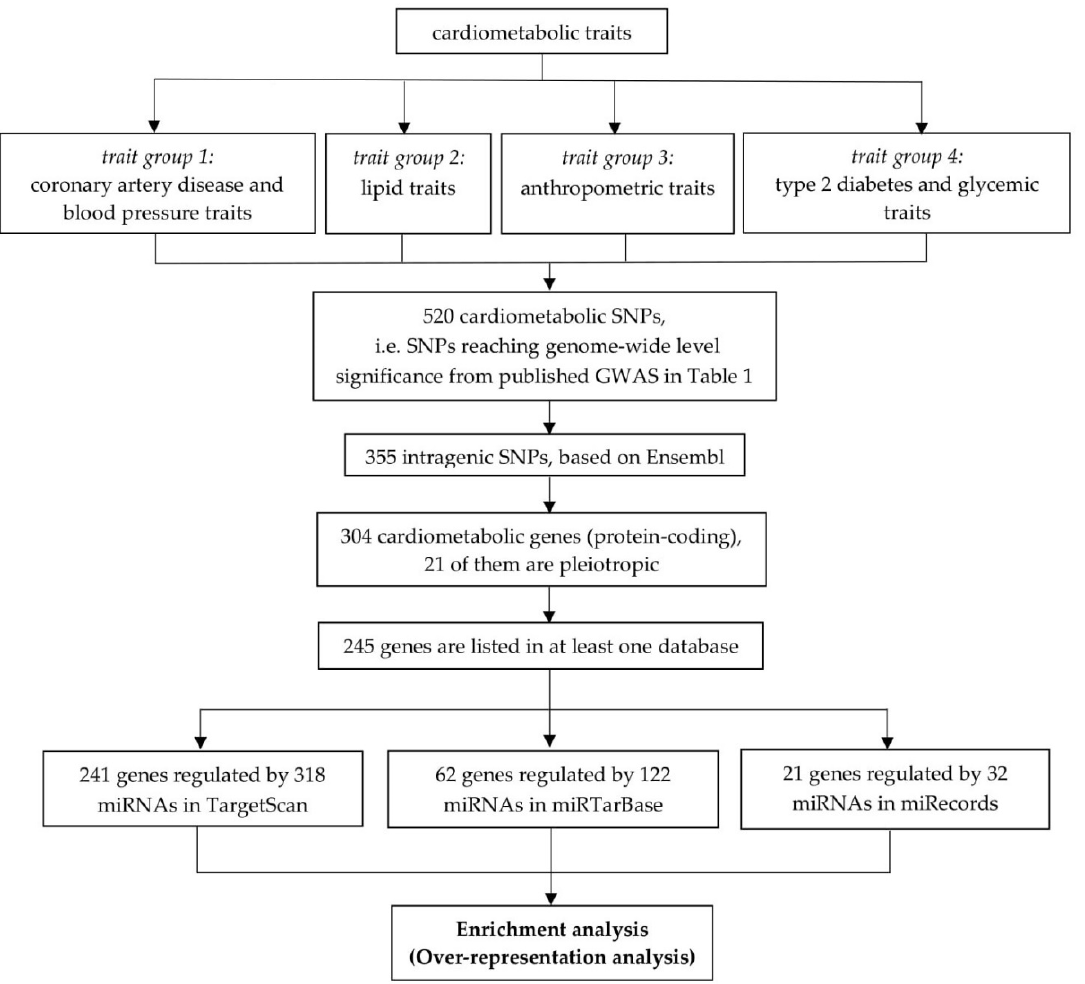
Figure 1. Retrieval of cardiometabolic genes and miRNAs. We extracted 520 SNPs from published GWAS on 20 cardiometabolic traits, of which 355 were intragenic. Those 355 SNPs corresponded to 304 cardiometabolic genes, of which 21 were pleiotropic genes. Enrichment analysis was carried out for cardiometabolic genes and miRNAs within each database (TargetScan, miRTarBase